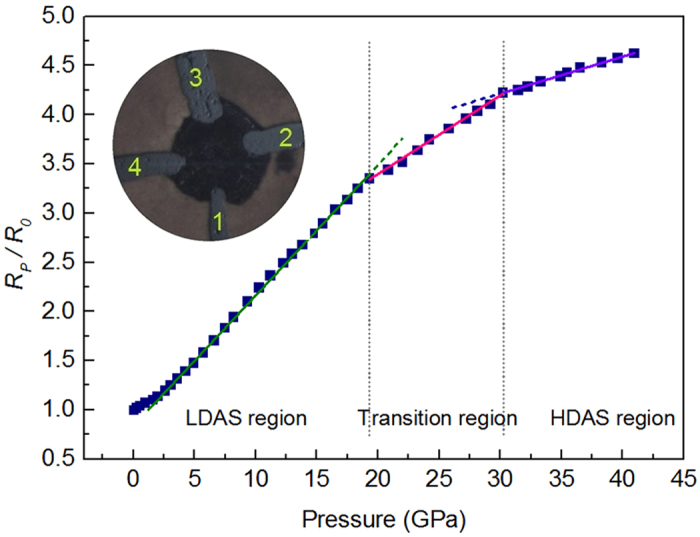
Relative resistance of the Yb62.5Zn15Mg17.5Cu5 metallic glass as a function of pressure.The inset shows the microphotograph of the sample with four Pt electrodes in chamber between two anvils at about 5 GPa conditions.